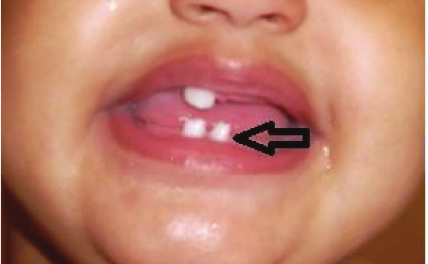
Figure 3: Pegged tooth (lower central incisor) seen at 12-month